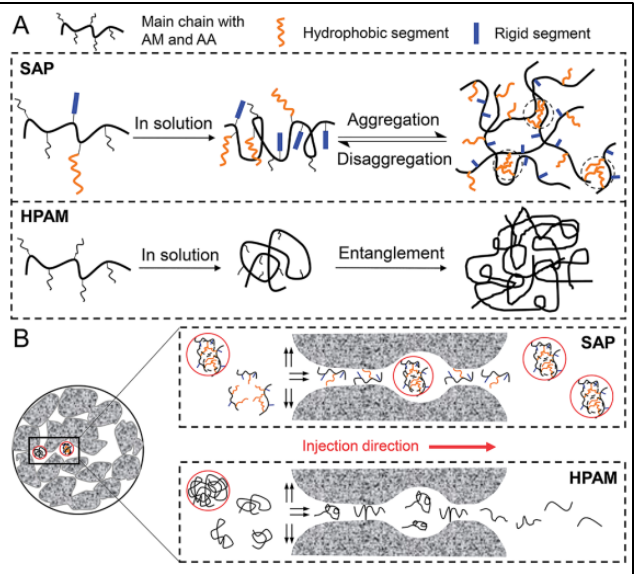
Figure 3. Comparison of the ( A ) morphologies and ( B ) flow behaviors of SAP and HPAM in porous media [73].